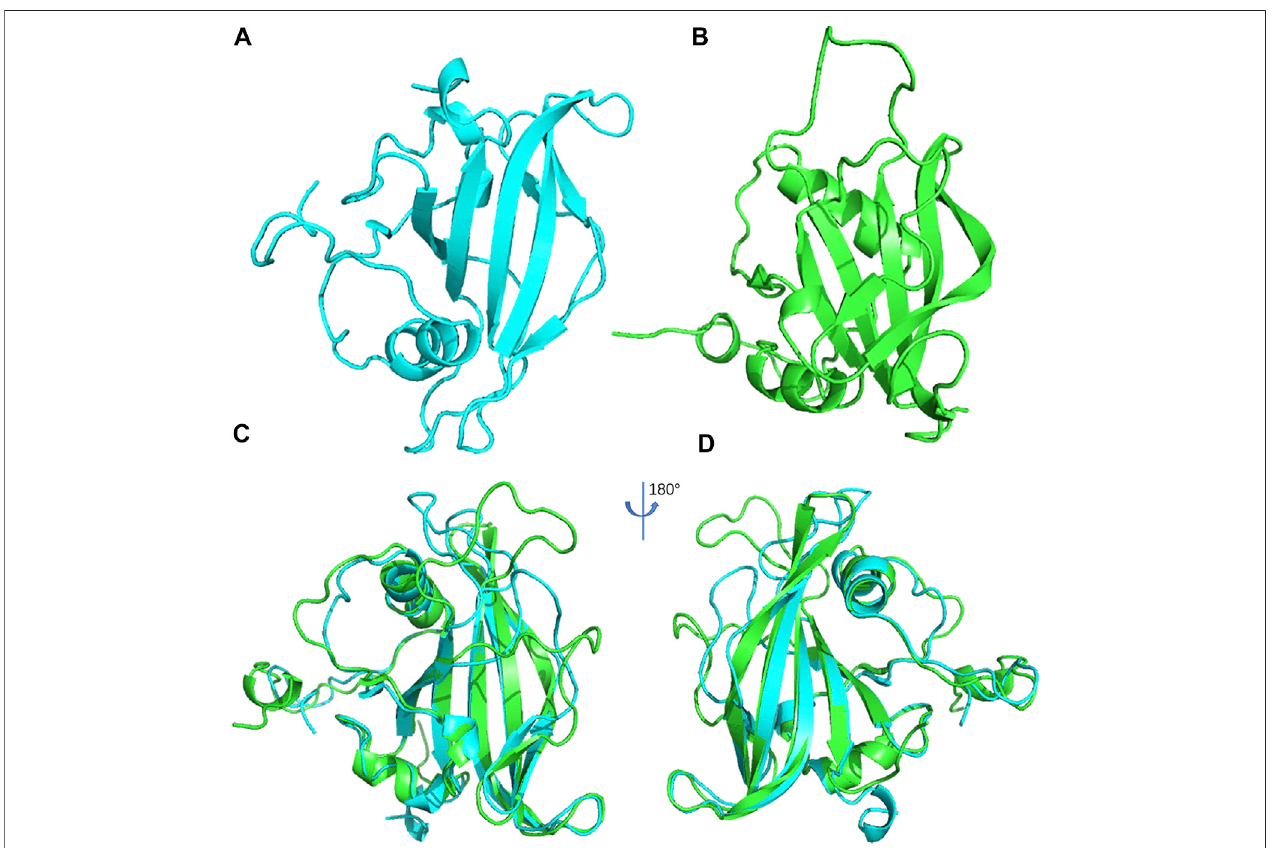
FIGURE 12 | The 3D structure of ANAC019 (A) and ItfNAC62 (B) and the superposition of protein structure for ANAC019 (blue) and ItfNAC62 (green) (C) and its 180 ° rotation (D) .